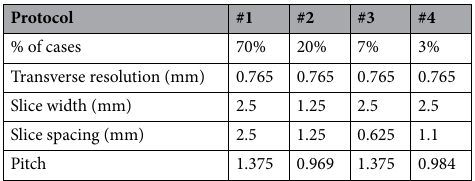
Table 2. CT acquisition protocols.